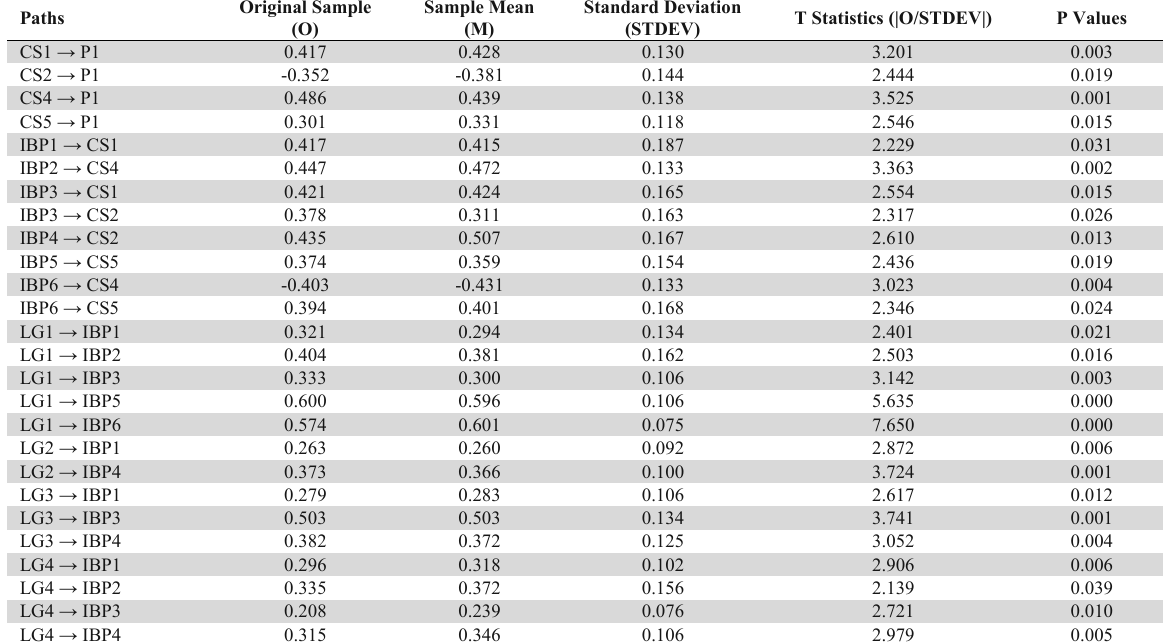
Hypothesis Testing Model 1